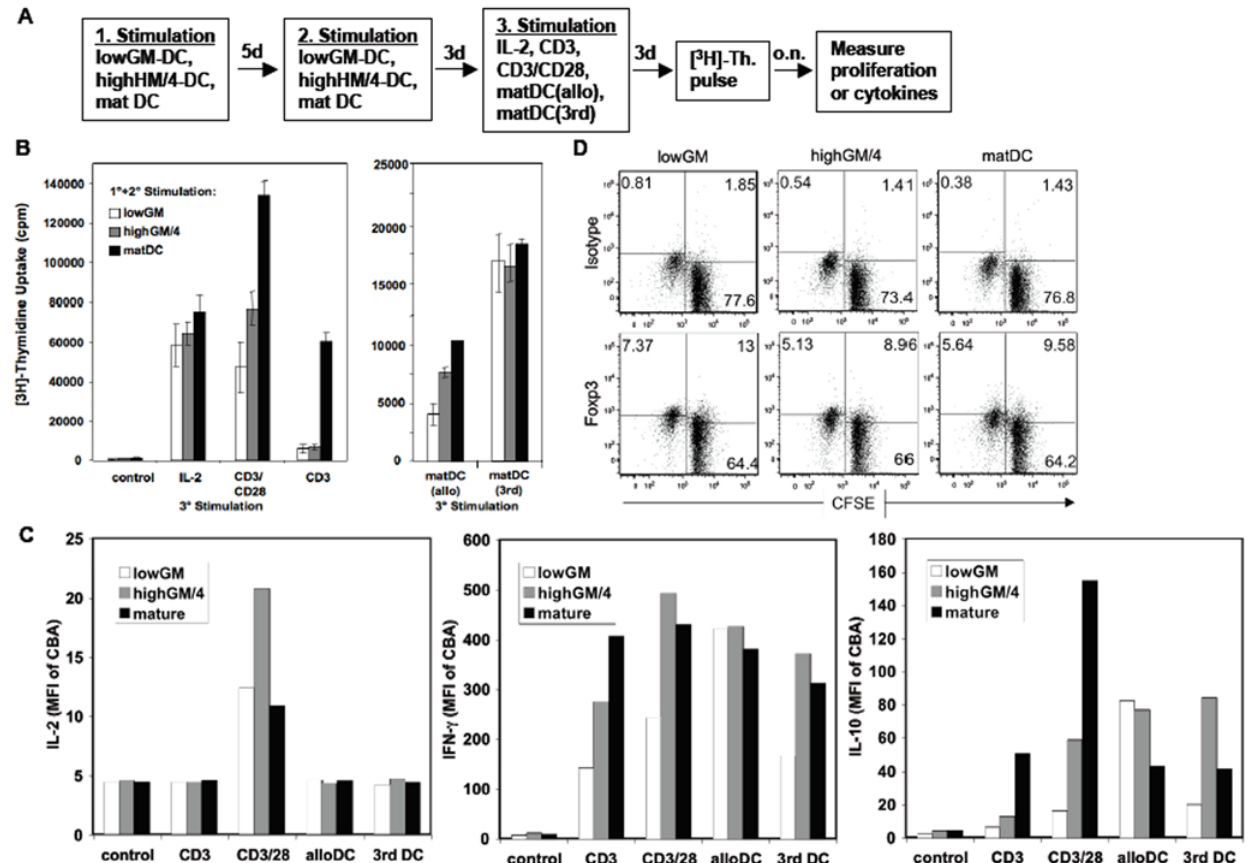
Figure 4. Allogeneic T cell anergy induction requires two stimulations by lowGM-DC. A. Allogeneic T cells were stimulated twice (for 5 days and then for another 3 days) with either immature lowGM-DC or immature highGM + IL-4-DC or mature highGM + IL-4-DC and then restimulated a third time for another 3 days with IL-2 or the indicated antibodies or LPS-matured DC from the original allotype (matDC allo) or a third party allotype (matDC 3rd) or cells were left without stimulation (control) for another 3 days. B. Then [ 3 H]-thymidine ([ 3 H]-Th.) was added overnight to measure proliferation. The data are representative of 4 independent experiments. C. Supernatants from the cultures shown in Figure 4B were tested for their content of IL-2, IFN- c , or IL-10 by cytokine bead array (CBA). The relative mean fluorescence values of the FACS analysis are shown. The data from one experiment shown are representative for 3 independent experiments. Values in bar graphs represent the mean 6 standard deviation error bars of triplicate cultures from one experiment. D. CFSE-labeled T cells were restimulated by the indicated DC type for 4 days and then stained for intracellular expression of Foxp3. Cells were measured by flow cytometry. Gating was performed on CFSE + cells and is plotted against Foxp3 or isotype. CFSE low cells represent allo-responsive proliferated